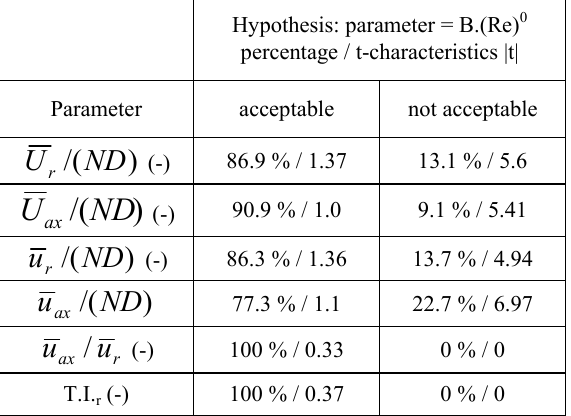
Table 2. Dimensionless velocities – effect of the impeller